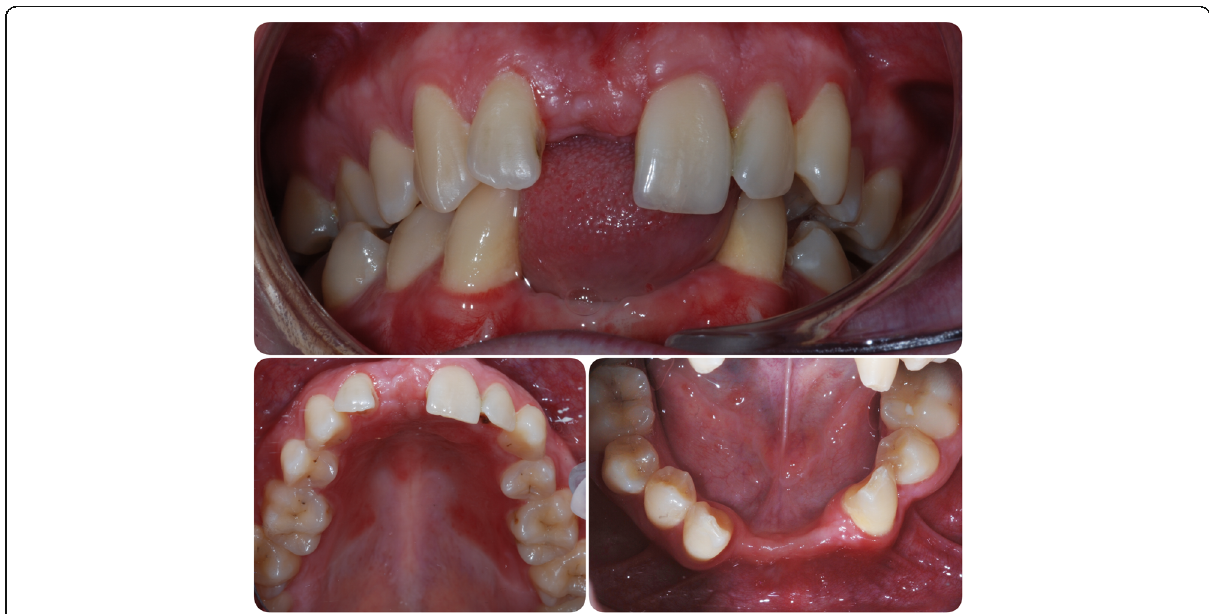
Fig. 1 Pre-operative photographs. Clinical situation at